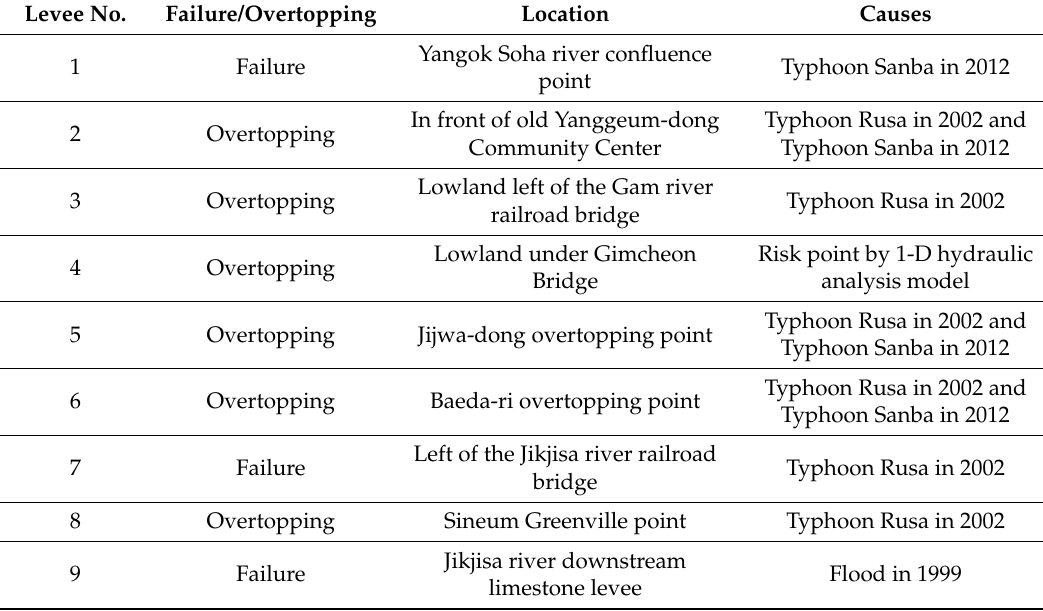
Figure 7. Levee failure and overtopping points. Table 1. Information on levee failure and overtopping points.